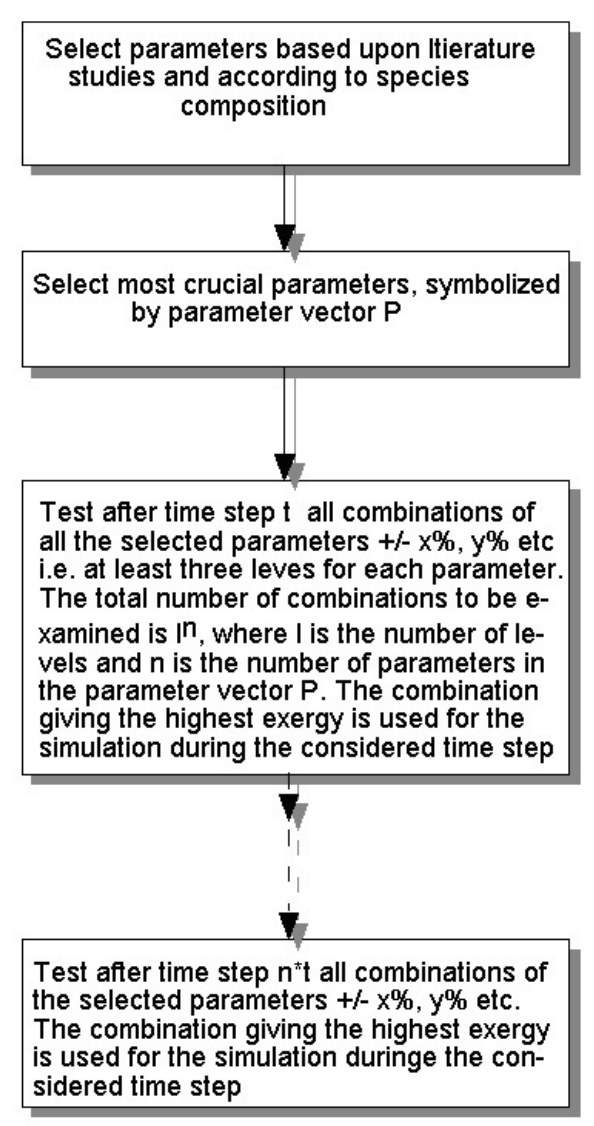
FIGURE 8. The procedure used for the development of